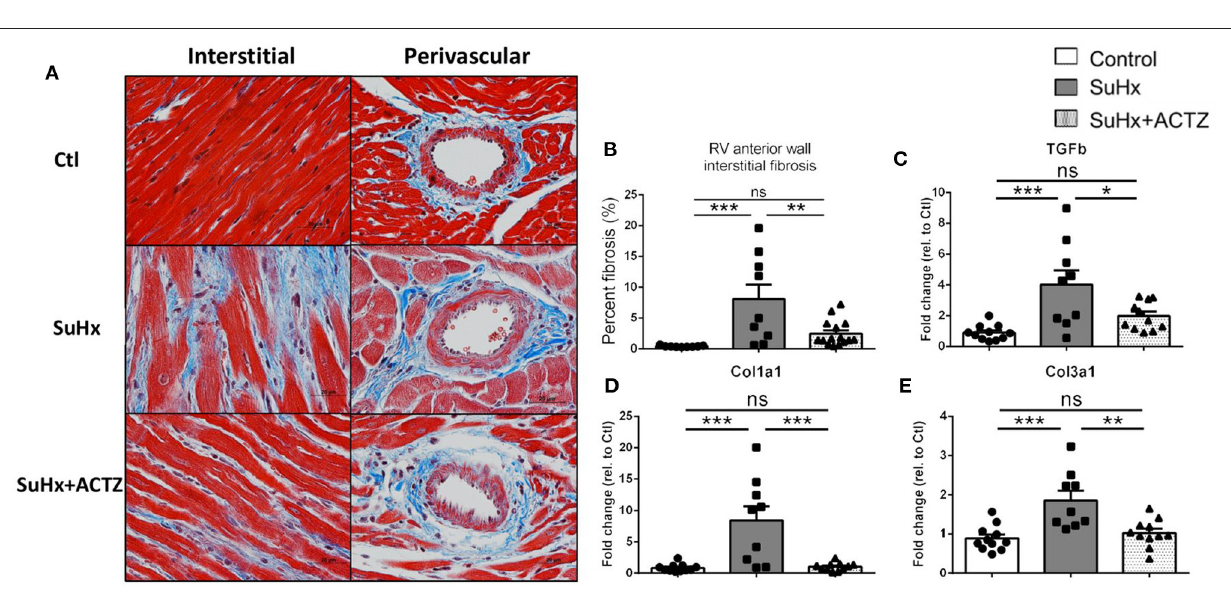
Frontiers in Cardiovascular Medicine |